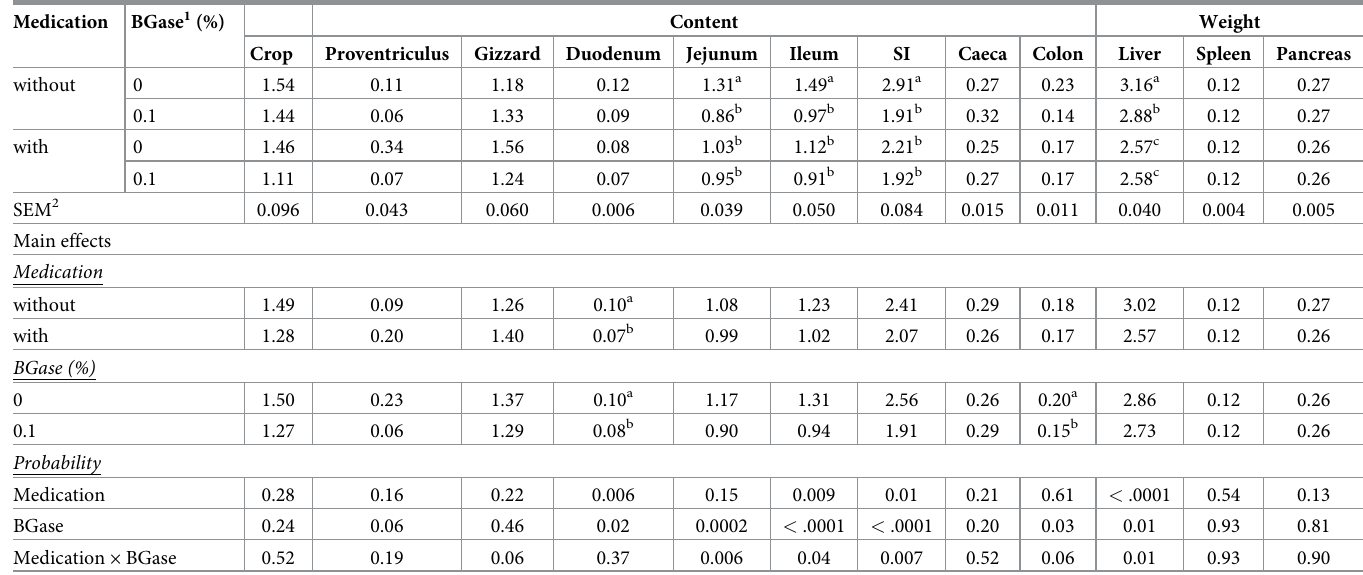
Table 19. Effects of diet medication and β -glucanase on gastro-intestinal content and organ weights as a percentage of body weight of broiler chickens at day 33 (Experiment 2).